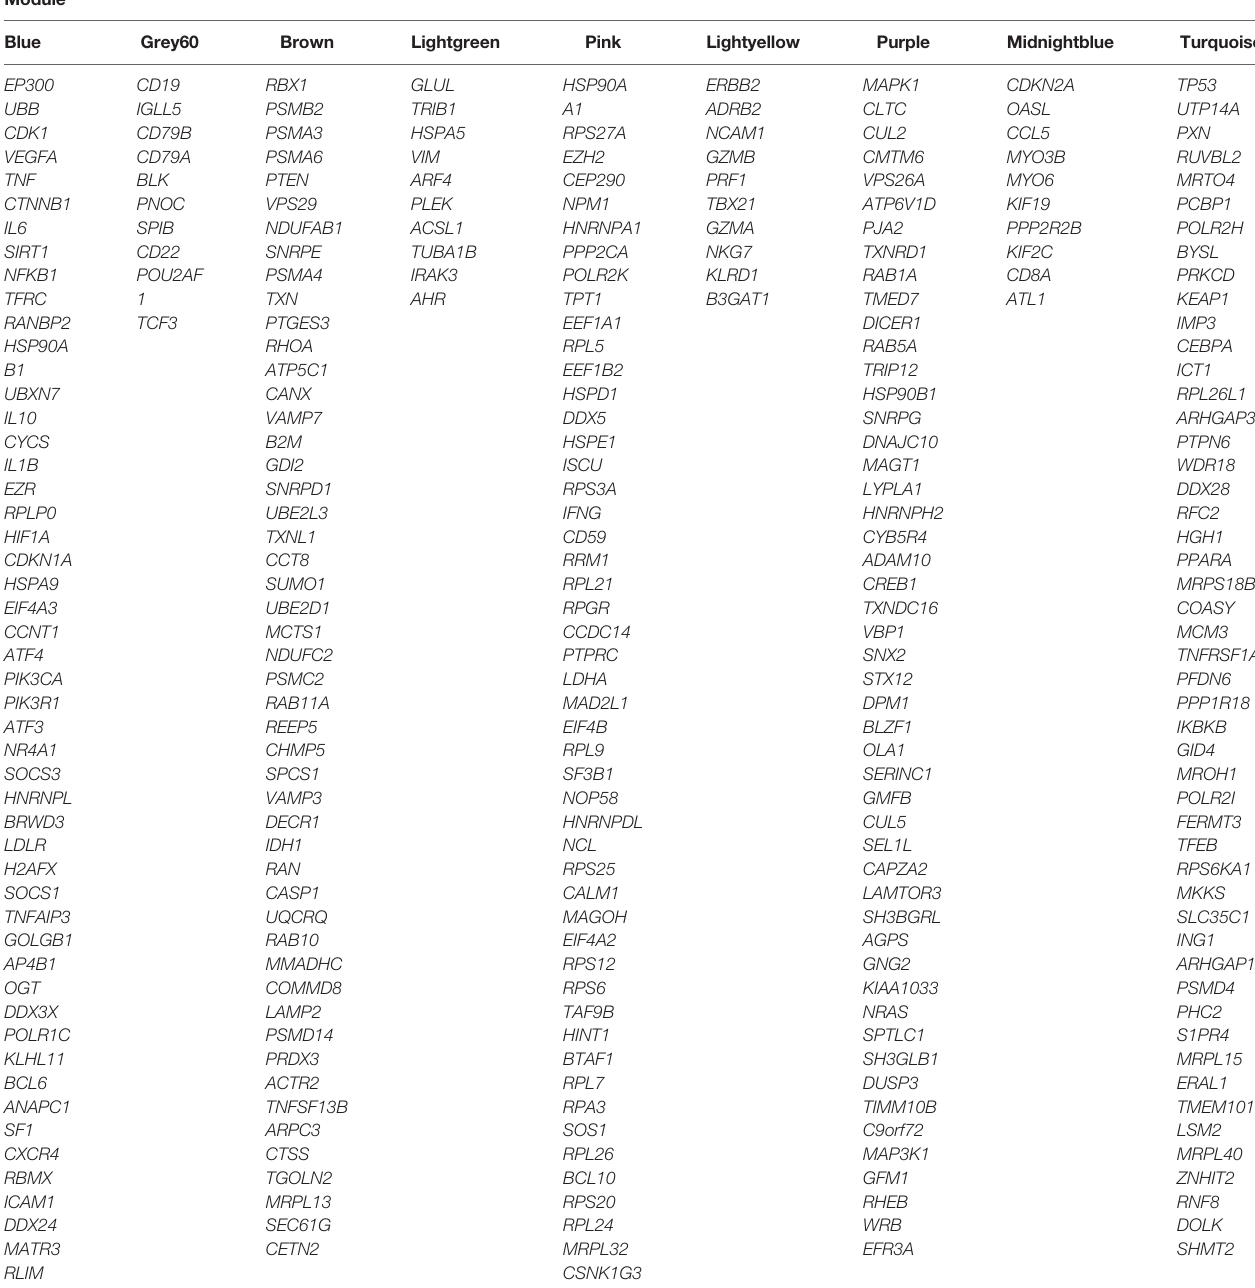
TABLE 1 | List of the identi fi ed hub-high traf fi c genes in the 9 candidate non-preserved modules. Module Blue